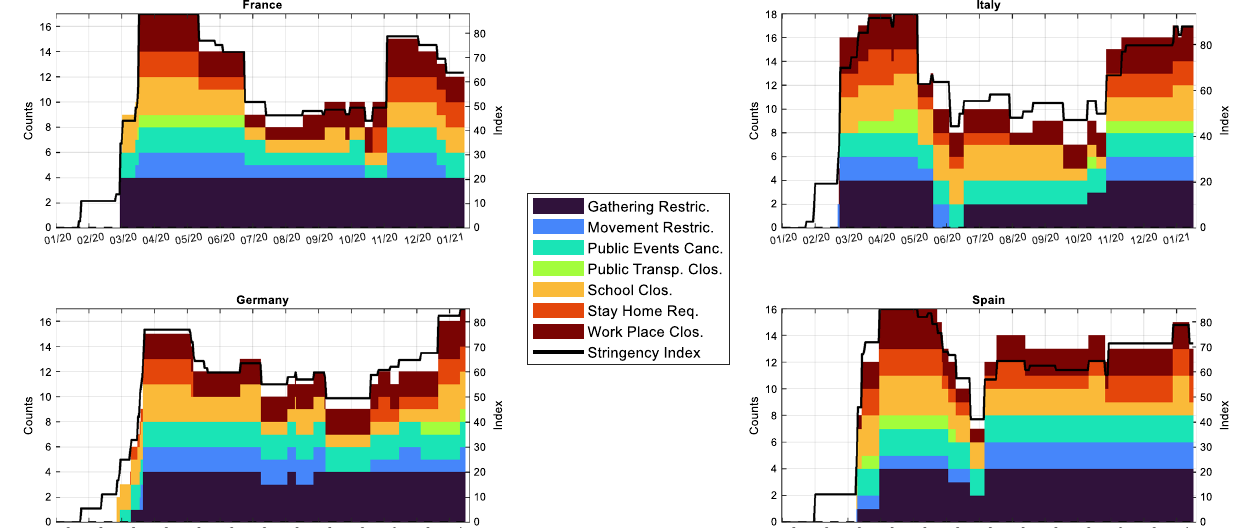
Figure 1. Line diagrams and bar-charts showing Government policy responses. The figure reports the line diagrams and bar-charts expressing the evolution of government policy responses in France, Italy, Germany and Spain over the starting year of the pandemic. Colored bars indicate the number of measures put in place within each category. Solid black lines indicate the Oxford Stringency Index (OxCGRT), an additive score of nine indicators recording information on containment and closure policies, such as school closures and restrictions in movement, and health policies. The left vertical axes represent the number of policies (counts) put in place by the Italian, Spanish, French and German governments, while the right vertical axes report the Oxford Stringency Index. The horizontal axes represent time (data on government policies are available at a daily